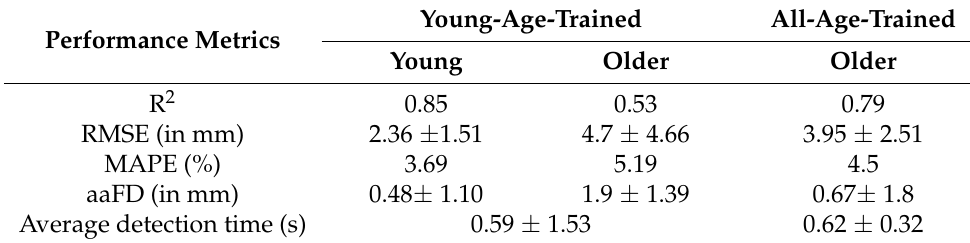
Table 1. Comparison of the performances of the two proposed ResNet + 2x-LSTM algorithms for young- age-trained and all-age-trained models. The table indicates the value of the coefficient of determination ( R 2 ), the root-mean-square error (RMSE) in millimeters (mm), the mean absolute percentage error with respect to the total length of the fascicles (in %), the average absolute frame difference ( aaFD ) of the individual subsegments in mm, and the average detection time (mean in seconds ±